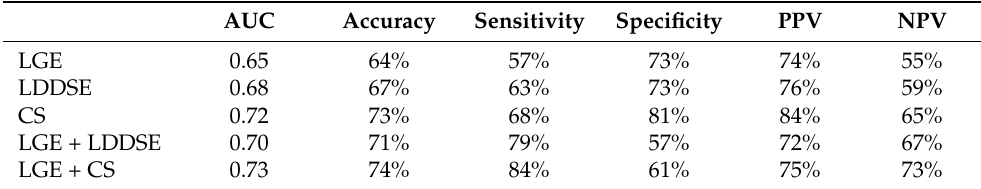
Table 5. Multiparametric analysis and prediction of functional recovery at follow-up.